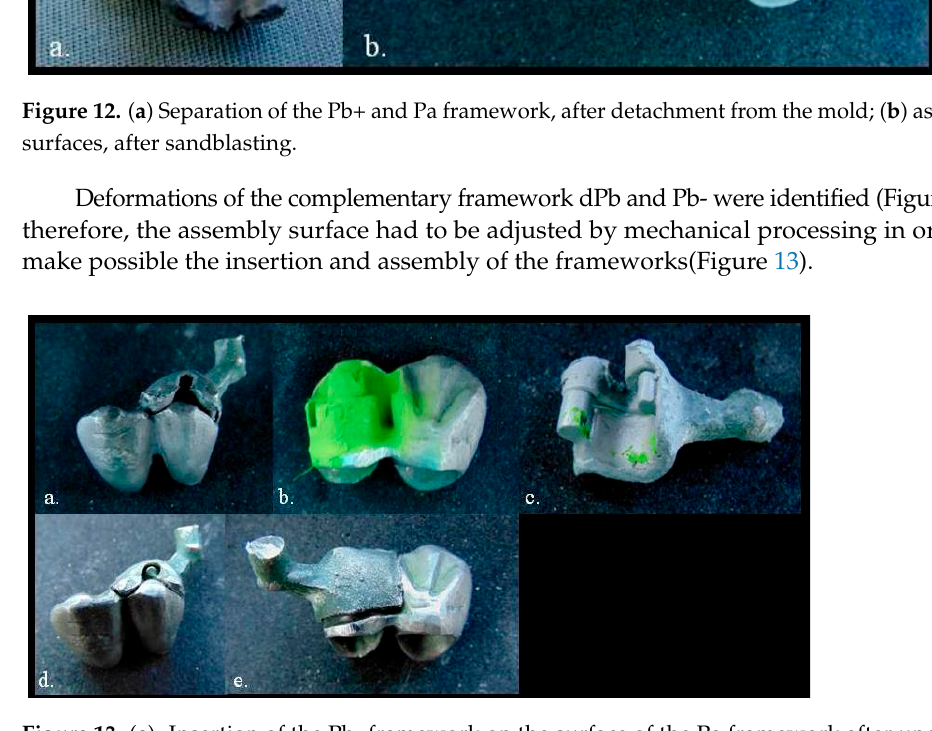
Figure 12. ( a ) Separation of the Pb + and Pa framework, after detachment from the mold; ( b ) assem- bly surfaces, after sandblasting.